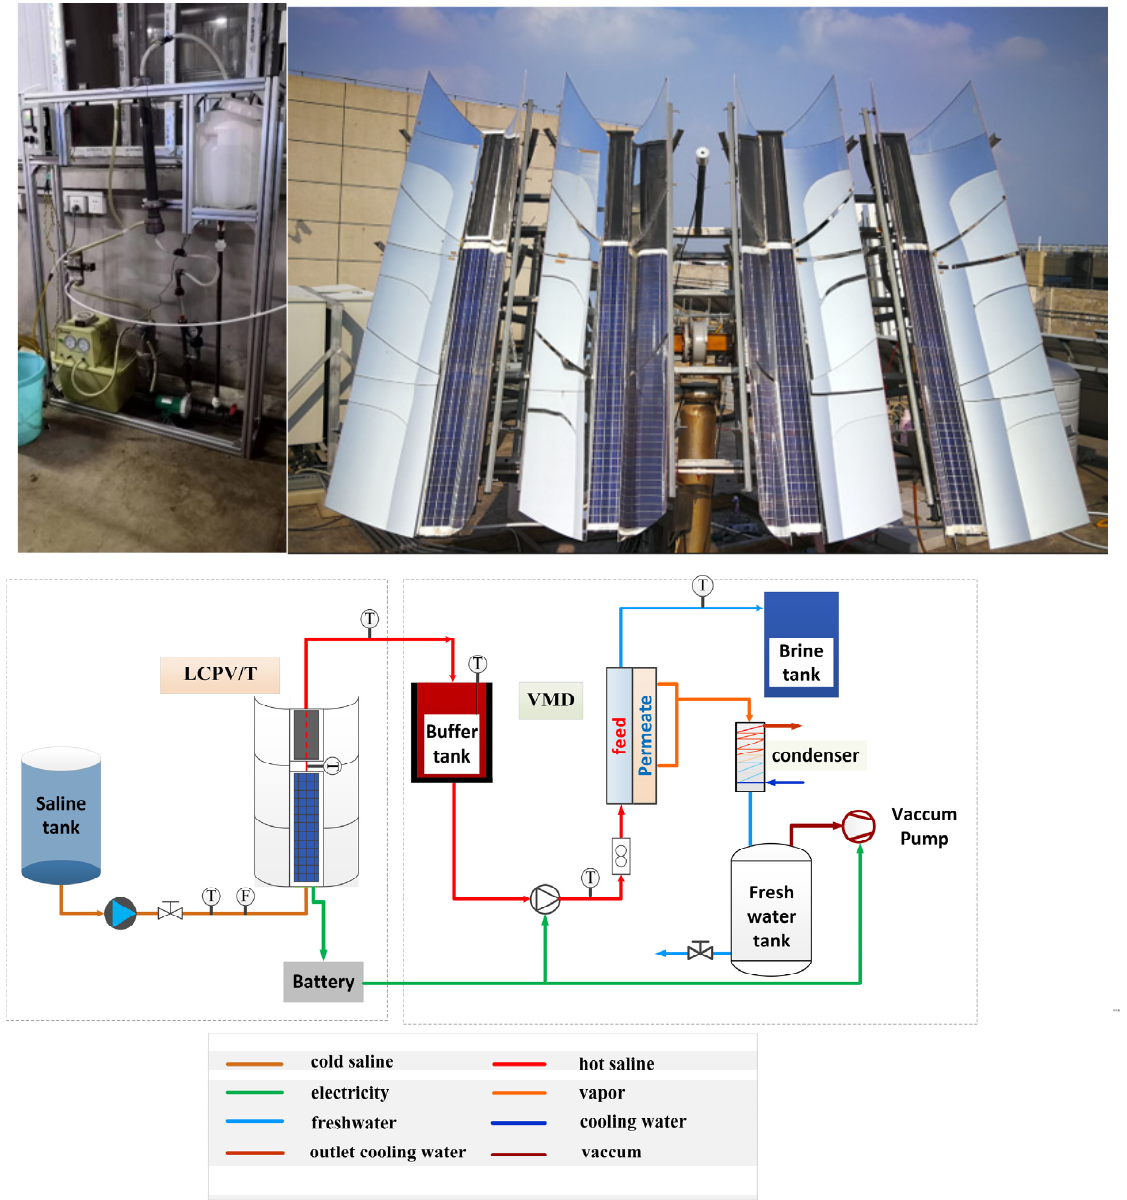
Figure 1. Schematic of LCPV/T-MD system and physical picture.